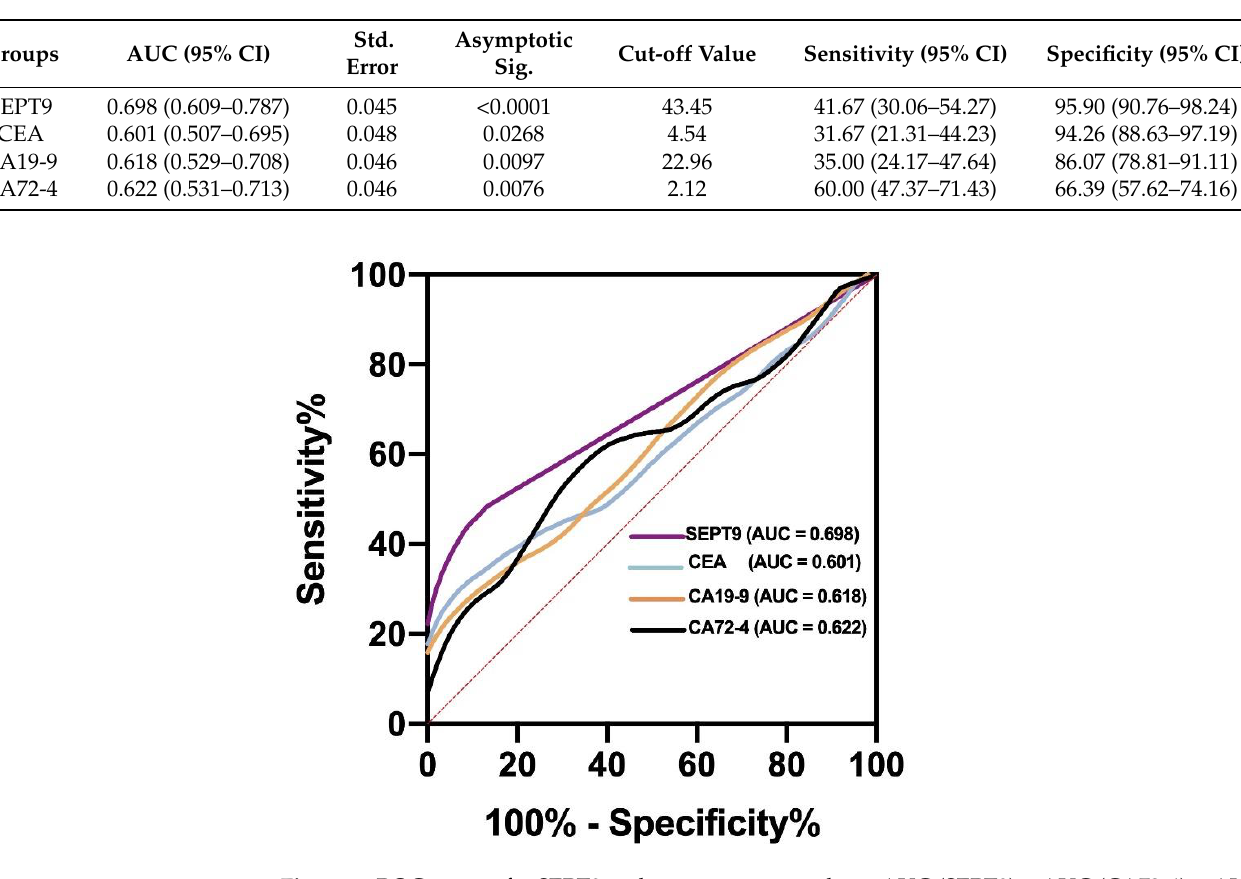
Figure 2. ROC curve of mSEPT9 and serum tumor markers. AUC (SEPT9) > AUC (CA72-4) > AUC (CA19-9) > AUC (CEA). AUC, the area under the ROC curve.